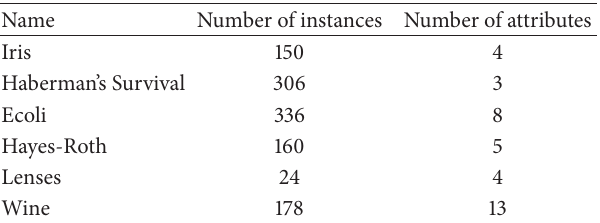
Table 1: Data sets of the experimental